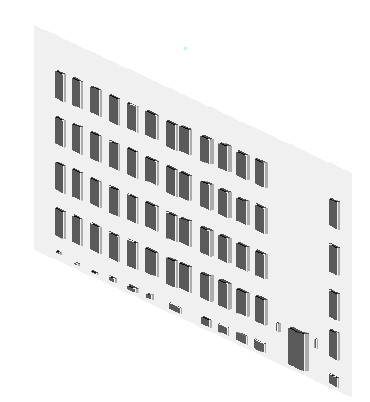
Figure 9. The data driven output model